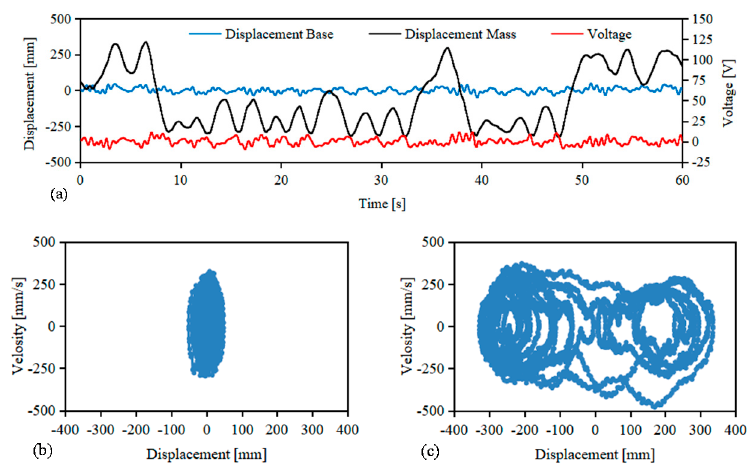
Figure 13. Measurement results of response vibration displacement and vibration power generation when vibrating with a random signal and a period signal 0.4 Hz. ( a ) Results of response vibration displacement. ( b ) Diagram of displacement velocity of vibration of the support. ( c ) Diagram of displacement velocity of vibration of the mass block.